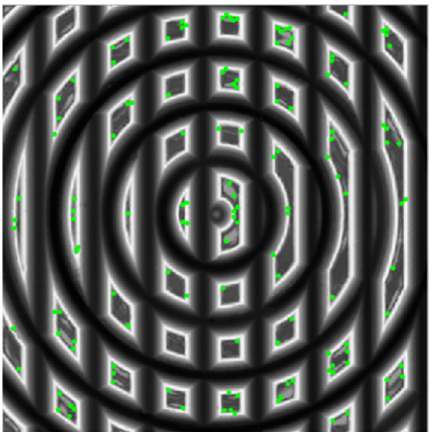
Figure 12. Feature point detection results marked with bright points.